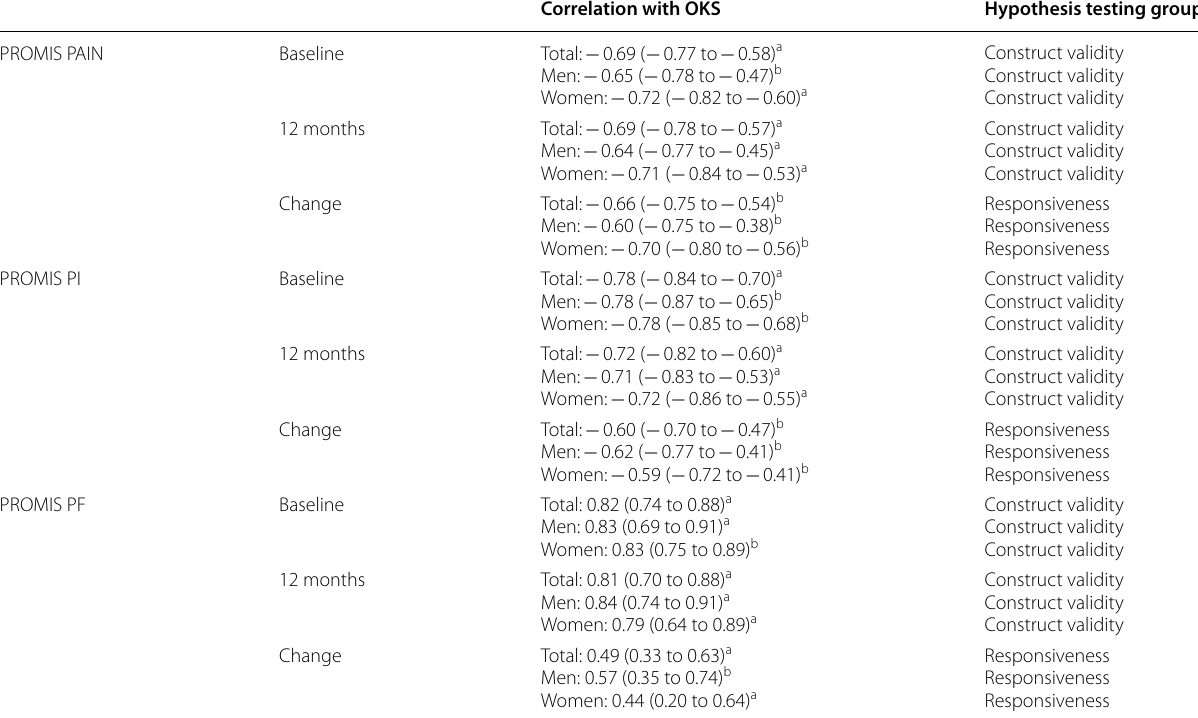
Table 2 Correlations between PROMIS scales and the